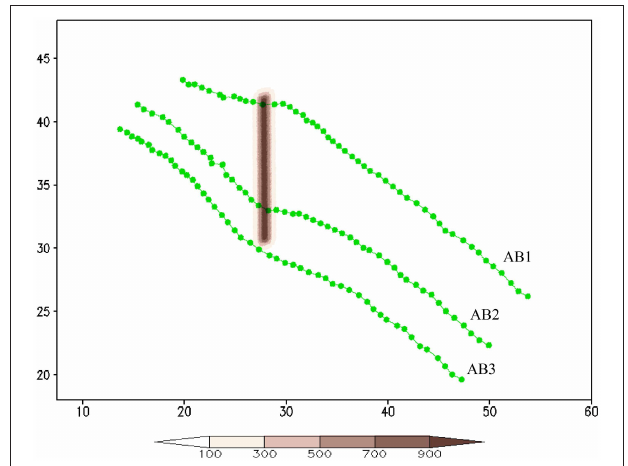
FIGURE 12 | The TC tracks for AB1, AB2, and AB3. The units of the coordinates in the x and y directions are 100km.